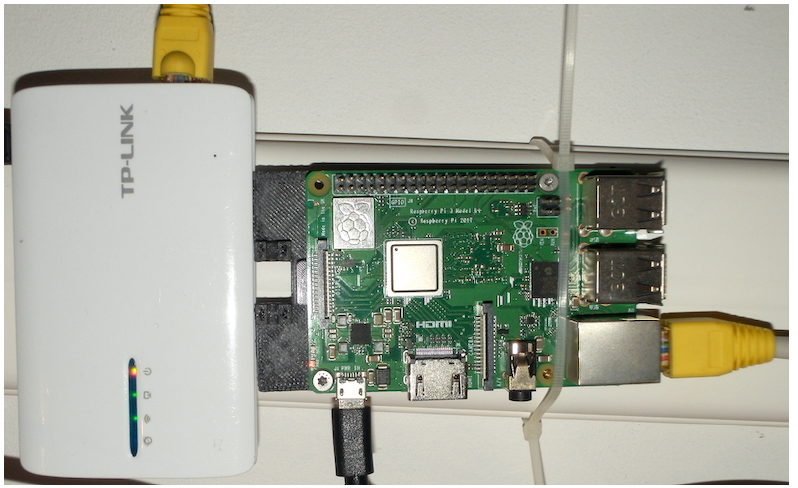
Figure A1. Edge-Device